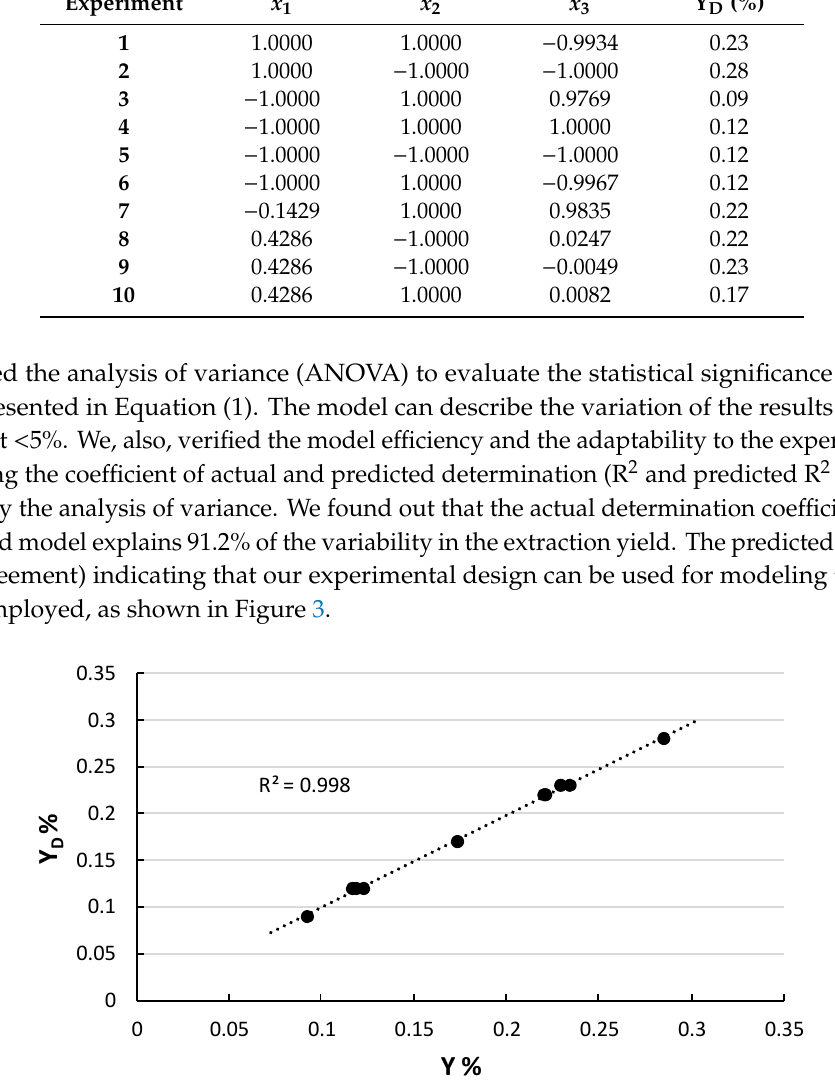
Figure 3. Experimental design yield (Y D ) versus experimental yield (Y).